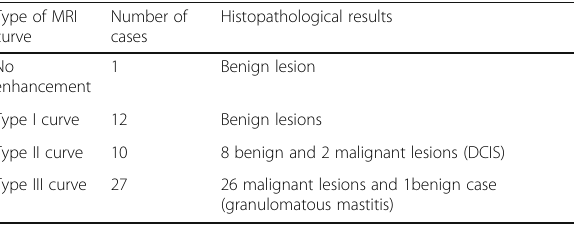
Table 4 The pattern of enhancement of lesions on